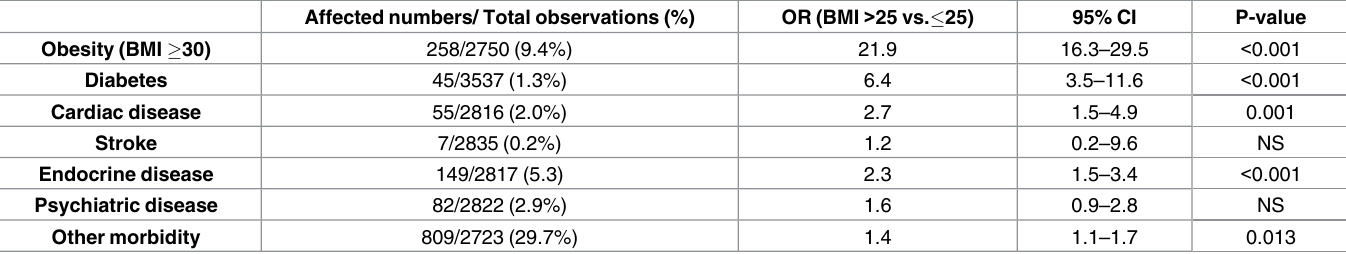
Table 2. High BMI ( > 25)at start of pregnancy and the risk of different diseases10–17 yearsafter pregnancy.